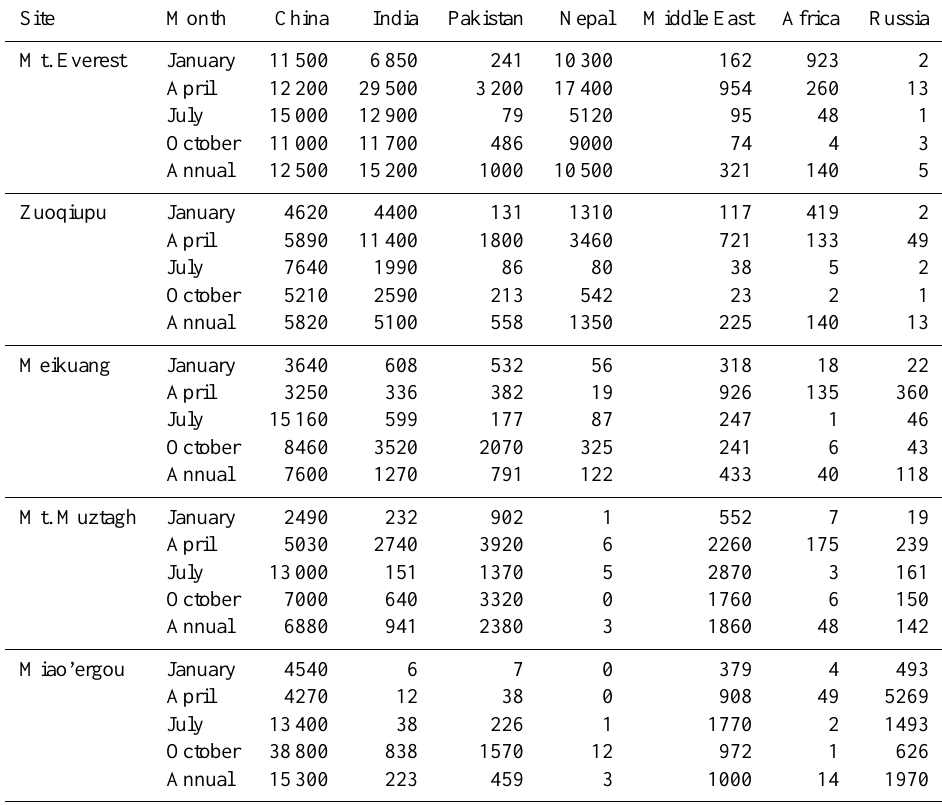
Table 2. National/regional origin of BC reaching the atmospheric column above the grid box containing the glacier sites for each month of simulation and an annual average. Units are kg per country or region per